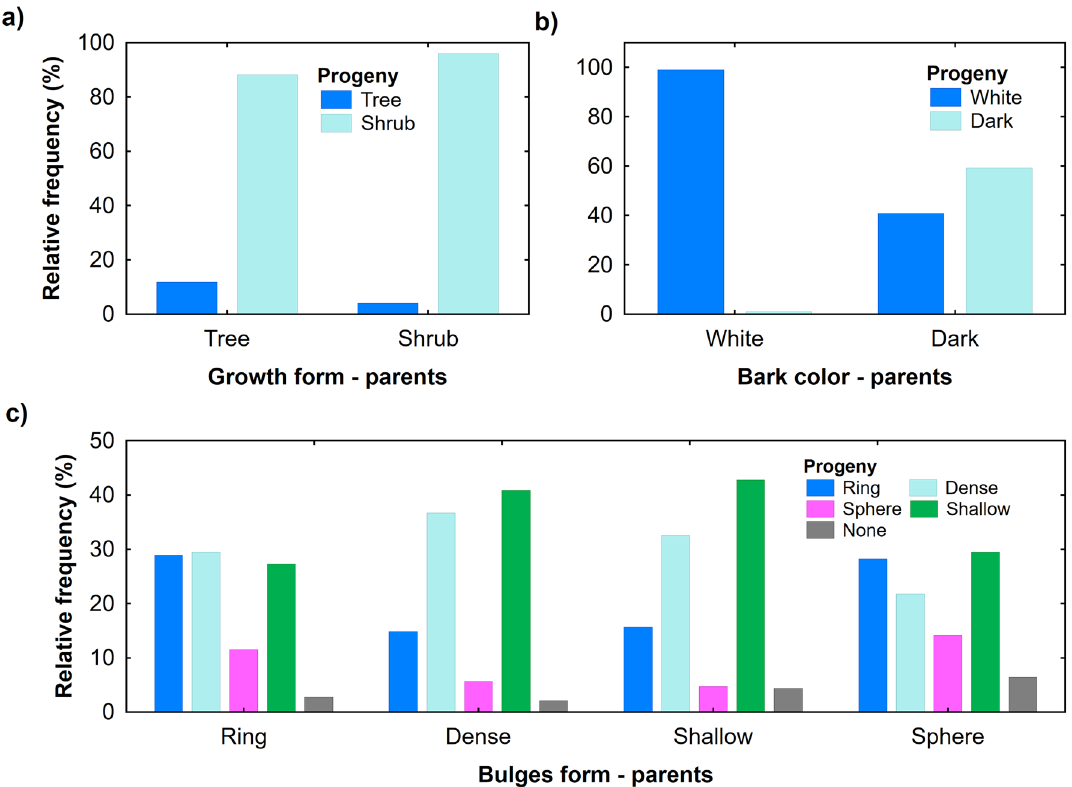
Figure 4. Correspondence of the curly birch progenies according to characteristics of parent clones displayed on x-axis: ( a ) growth form, ( b ) bark colour, and ( c ) shape of the bulges, values on y-axis show relative frequencies of progenies in selected parent